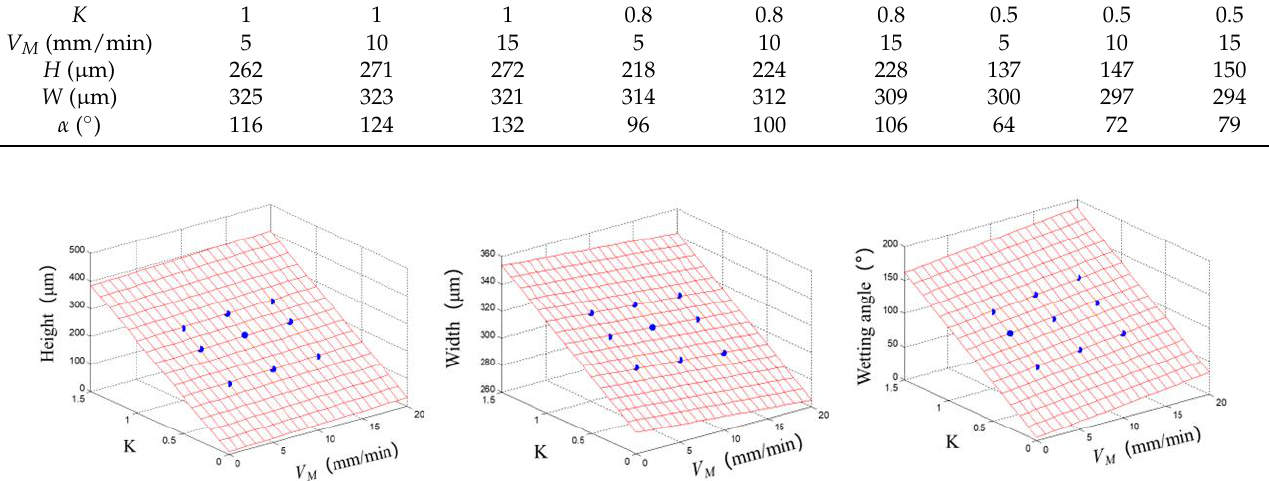
Figure 10. Multiple regression analysis for H , W and α of single-track versus K and V M .